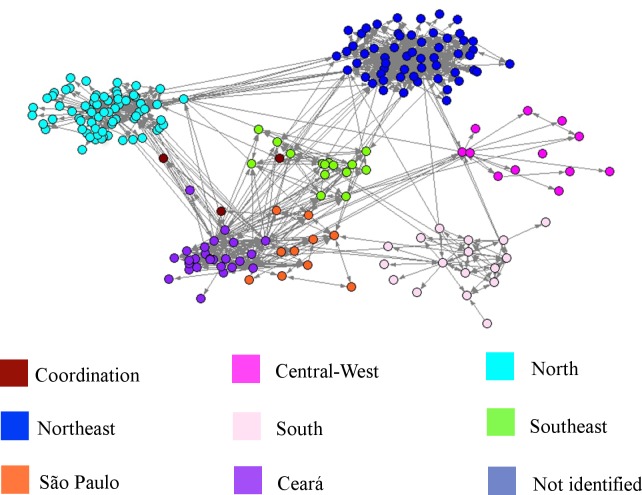
Network of Relationships Among Tutors.